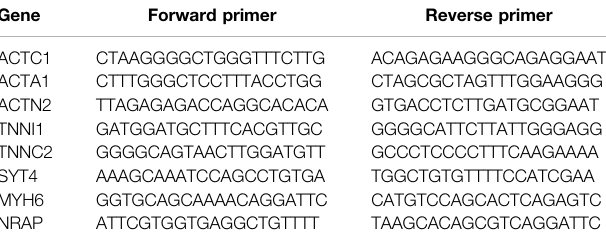
TABLE 1 | qRCR related primers.